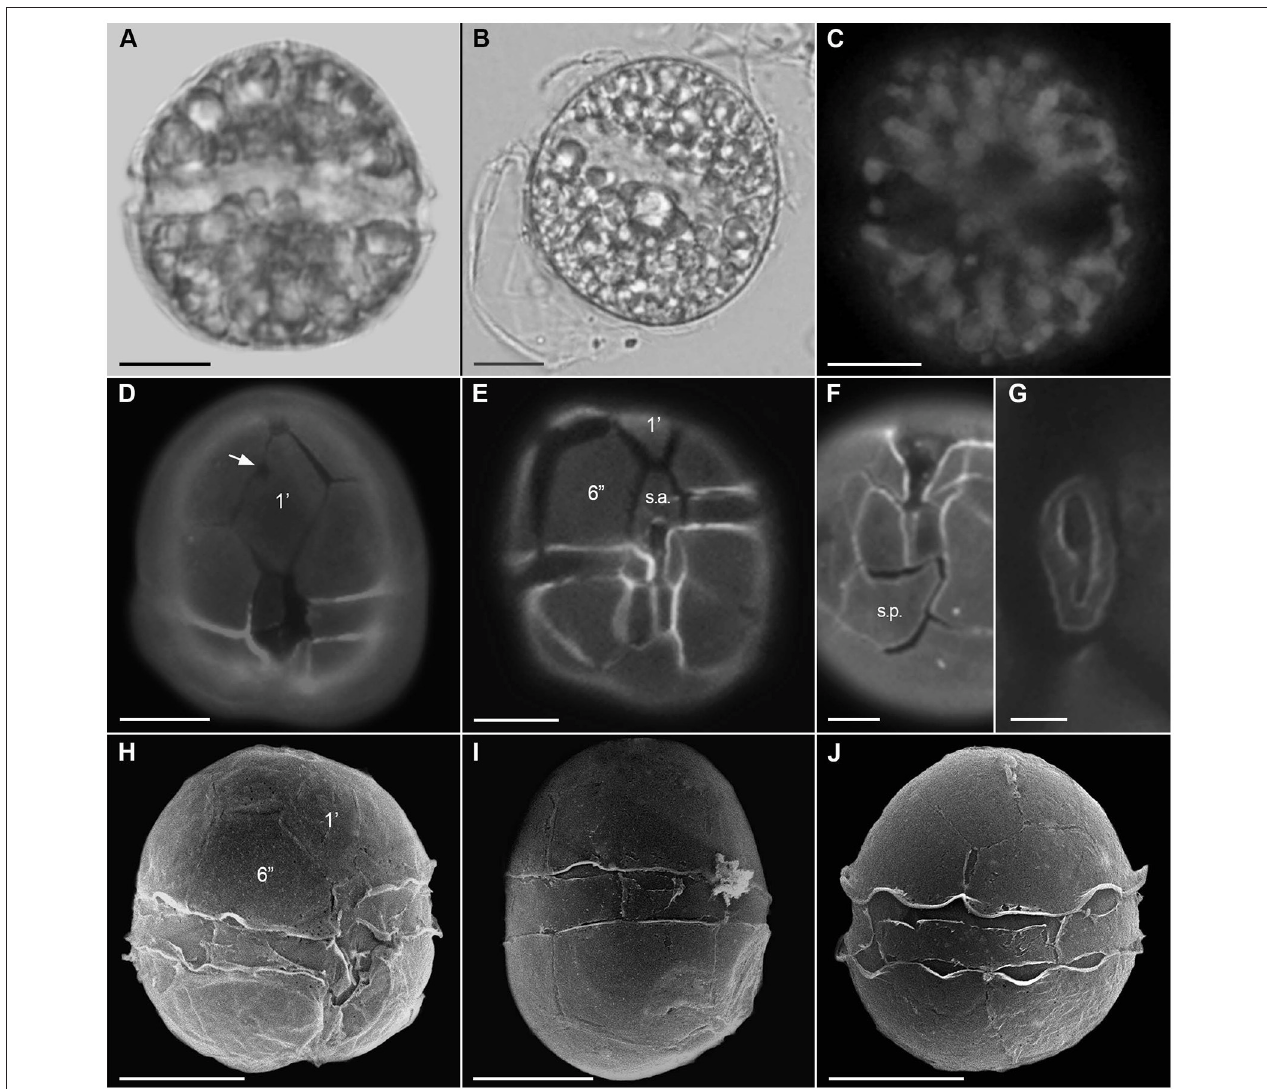
FIGURE 3 | Alexandrium tamutum . Light micrographs (A,B) , epifluorescence micrographs (C–G) , and scanning electron micrographs (H–J) . Live cell (A) , cyst (B) , chloroplast autofluorescence (C) , ventral view (D,E) , showing the firth apical plate (1 ′ ) with ventral pore (arrow), sixth precingular plate (6 ′′ ), and anterior sulcal plate (s.a.), antapical view showing posterior sulcal plate (s.p.) (F), apical pore complex (G) , ventral view showing the firth apical plate (1 ′ ) and large sixth precingular plate (6 ′′ ); lateral view (I) , and dorsal view (J) . Scale = 10 µ m (A–E,H–J) , 5 µ m (F) , 2 µ m (G)